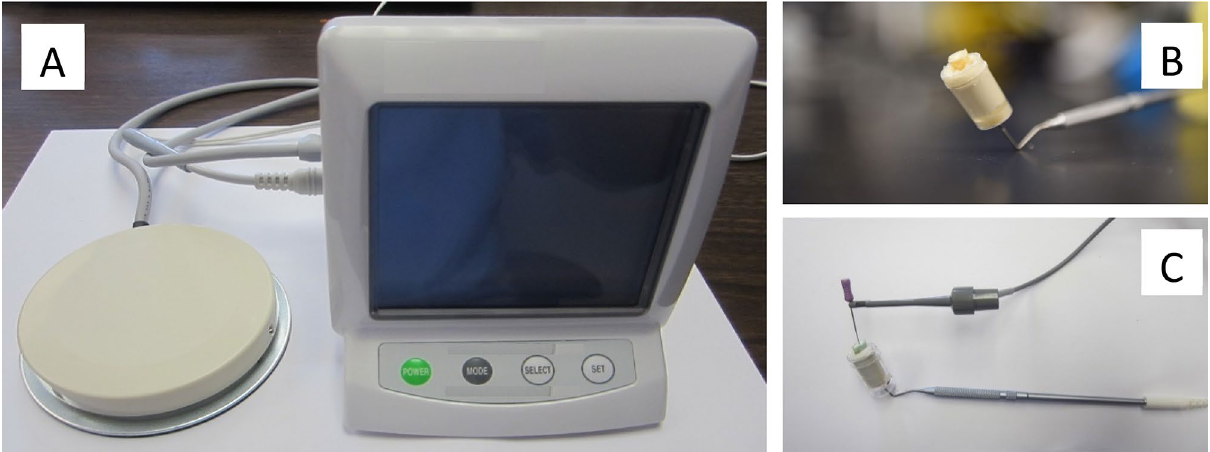
Figure 2. ( A ) represents the prototype used in the study. For circuit completion, a hole was bored in the inferior portion of the cap to allow the counter electrode, a modified periodontal probe, to be inserted ( B ). The specimen was mounted in alginate, leaving approximately 2 mm of tooth structure above the alginate ( B ). The active electrode was created by connecting an insulated #10 endodontic hand file to the device ( C